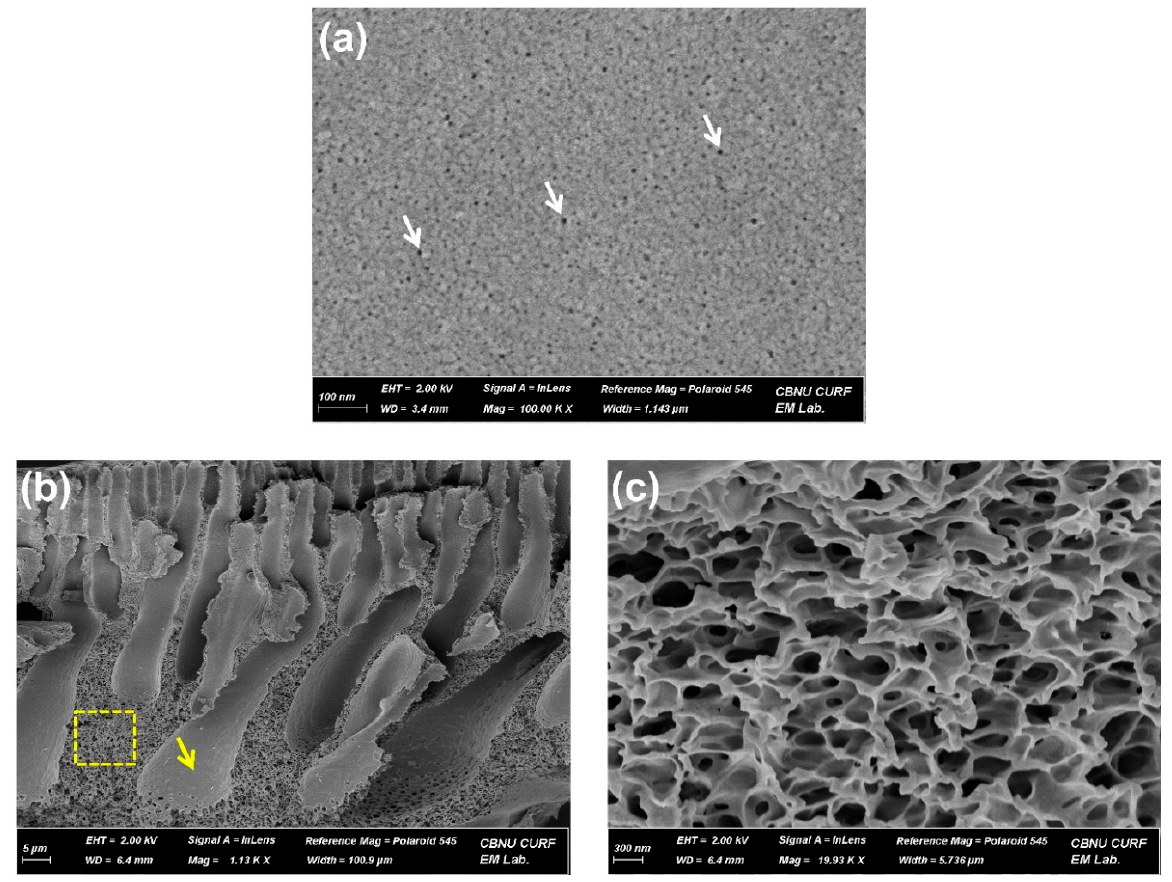
Figure 3. ( a ) Surface and ( b ) cross-sectional SEM image of the UF membrane prepared with a 20 wt% PSf solution. The white arrows indicate surface pores ranging from about 5 to 10 nm. The yellow arrow and dotted box mean finger-like and sponge-like regions, respectively. ( c ) The magnified SEM image of a sponge-like region.